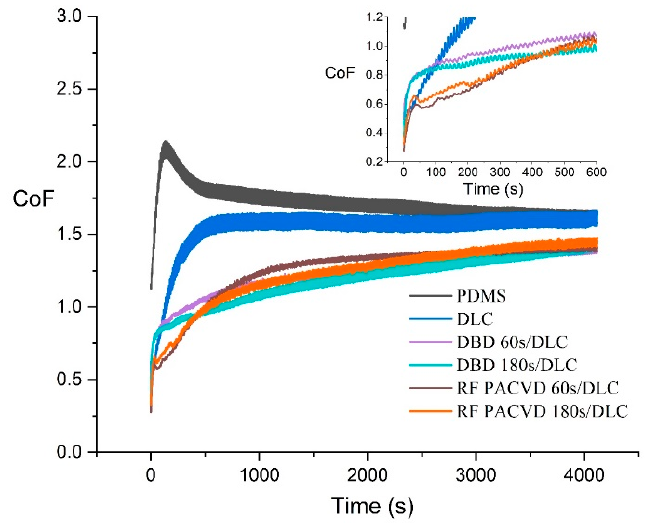
Figure 6. Changes in the coefficient of friction of substrates used in the tribological tests.